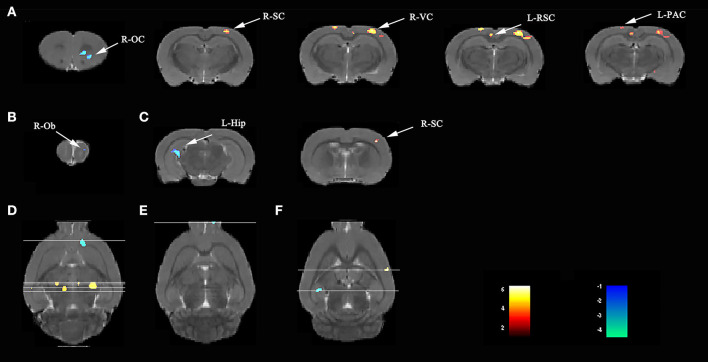
Lipopolysaccharide (LPS) exposure induced both short- and long-term functional connectivity (FC) changes in the aged rat brain. LPS exposure caused FC changes in (A) 3 days, (B) 7 days, and (C) 31 days. (D–F) Localization for different regions of interest (ROIs) on day 3, 7, and 31. Data were analyzed by one-way ANOVA followed by the post-hoc two-sample t-test. A voxel-level height threshold of p < 0.001 and a cluster-extent threshold of 20 were considered as statistically significant. Both the left and right hippocampus were used as seed voxels.